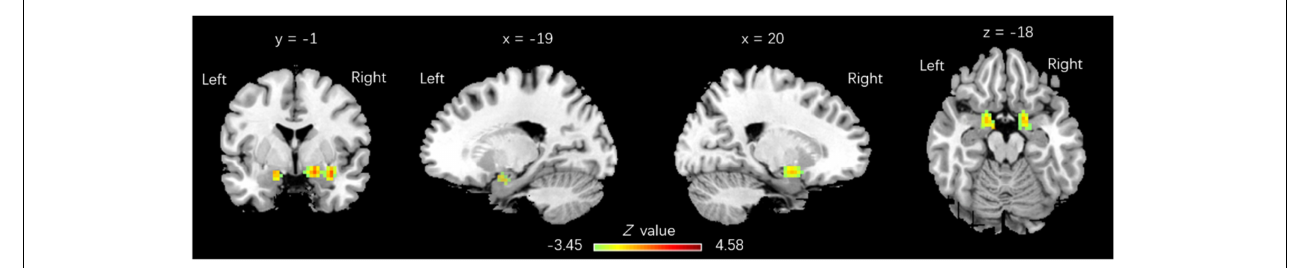
FIGURE 2 | Regions with functional connectivity (FC) increase linked to pIC.L. pIC.L-related FC with a significant increase was observed in bilateral amygdala, with 90 voxels on the left ( x = –18, y = 3, z = –12; p = 0.016) and 185 voxels on the right ( x = 18, y = 3, z = –15; p = 0.017), family wise error (FWE)